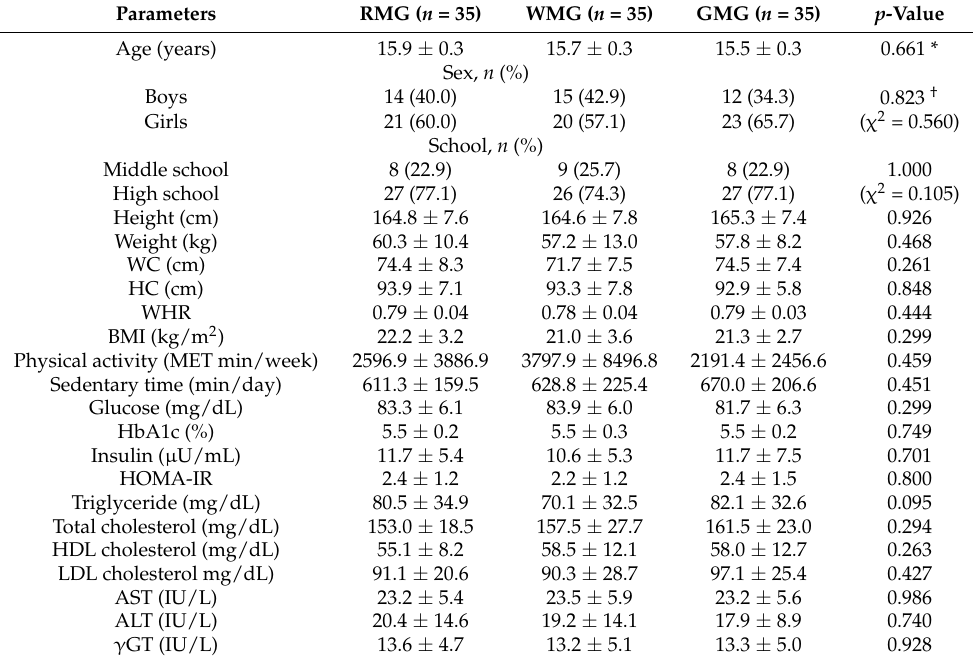
Table 2. Baseline general characteristics, clinical and biochemical parameters of the study